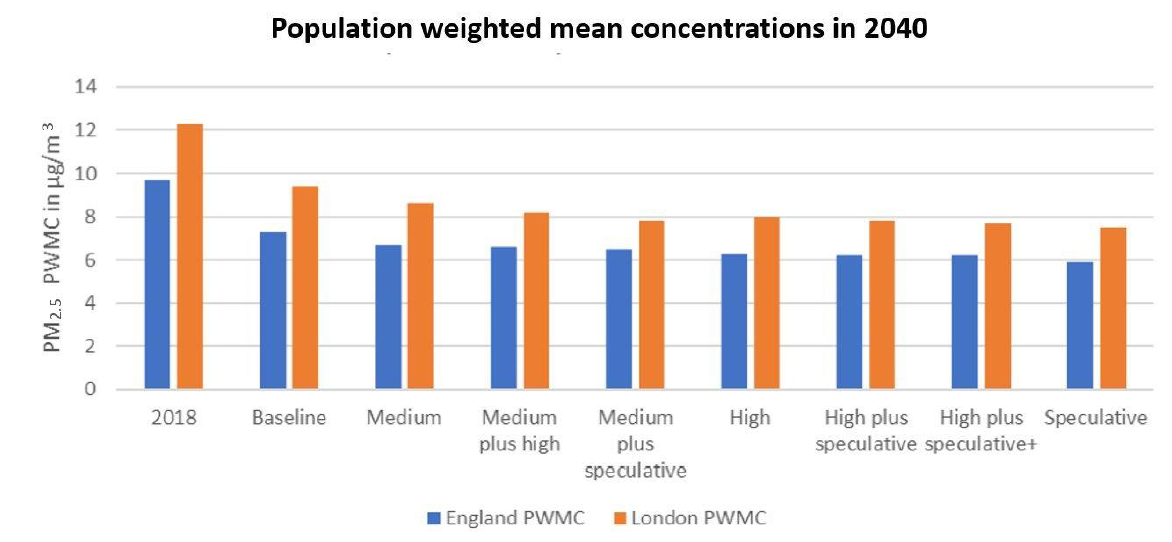
Figure 10. Population-weighted mean concentrations for the different scenarios in 2040; these provide the basis for deriving population health impacts and population exposure reduction targets alongside monitoring data.